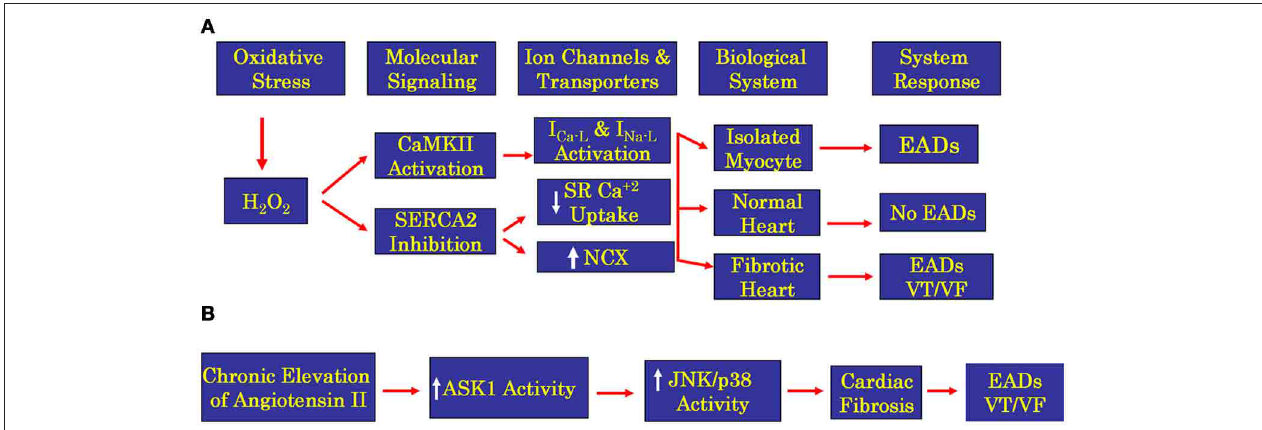
EADs in isolated cardiac myocytes however, at the whole heart level only the presence of enhanced cardiac fibrosis could lead to propagated EADs by the mechanism of triggered activity leading to VT/VF. ASK1 is apoptosis signaling kinase 1, is a member of mitogen-activated protein kinase kinase kinase family that activates JNK (c-Jun N-terminal kinase) and p38 kinase (p38 mitogen-activated kinase) eventually initiating transcription causing hypertrophy and